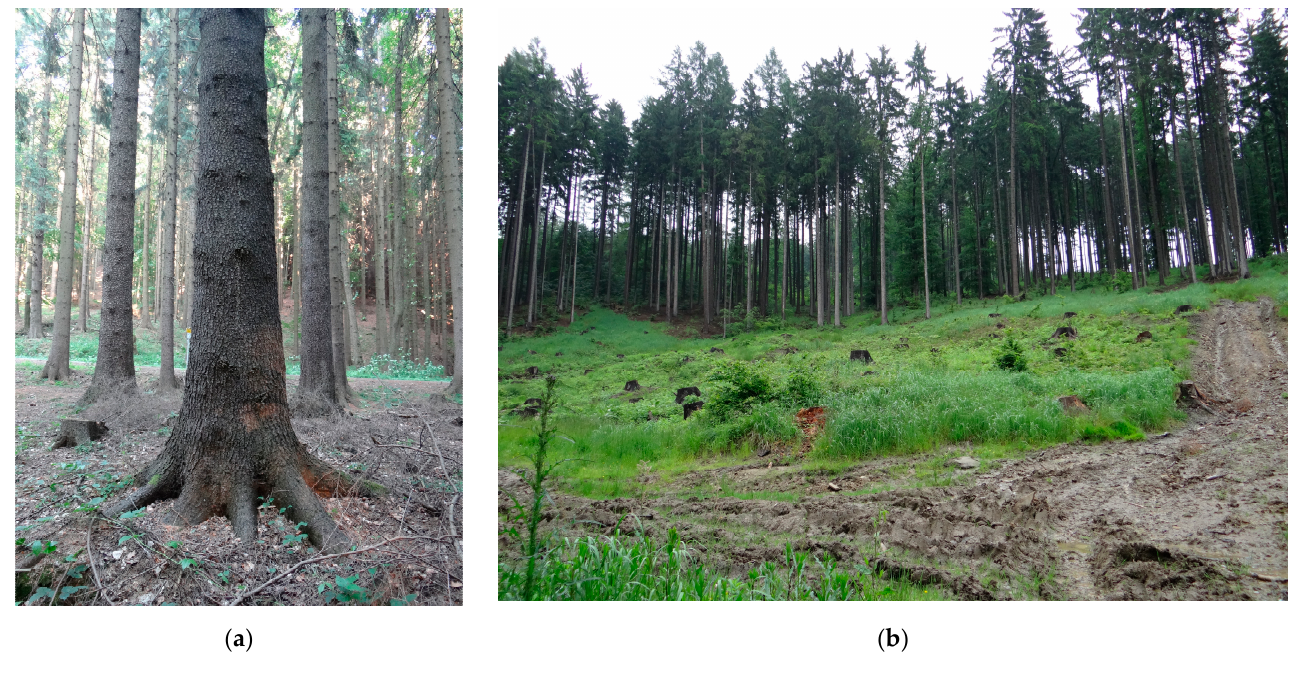
Figure 7. Forest stand with dominancy of Picea abies with occurrence of C. heros, forest management unit 451: ( a ) detail forest stand structure in alluvium of stream; ( b ) clear-cut regeneration of forest stand with dominancy of P. abies .